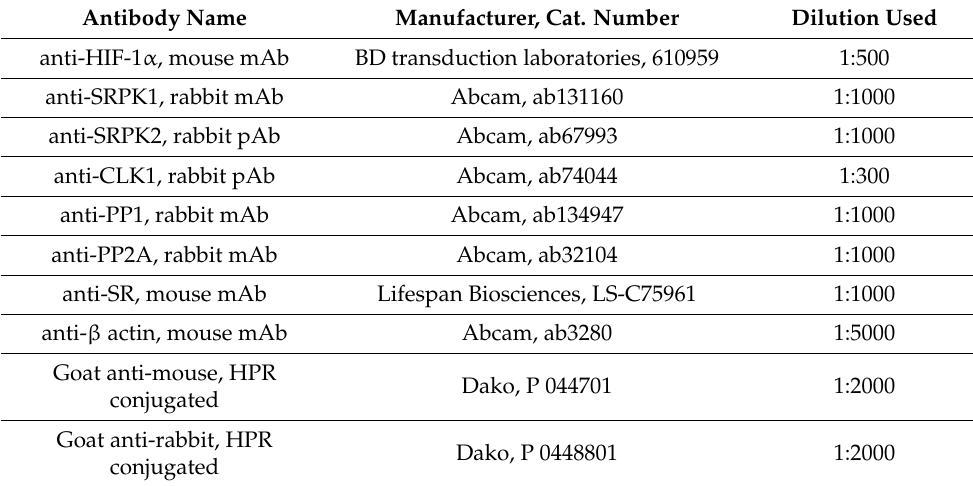
Table 2. Antibodies